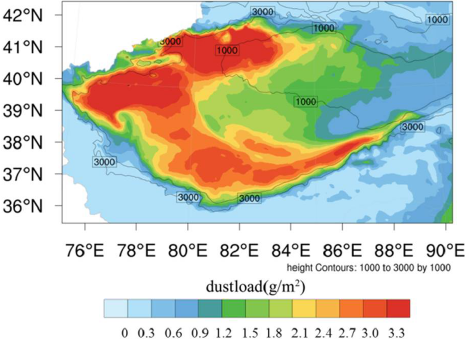
Figure 9. Spatial distribution of the total vertical column dust load (g m −2 ) over the TB on 29 April 2015, at 18:00 UTC.